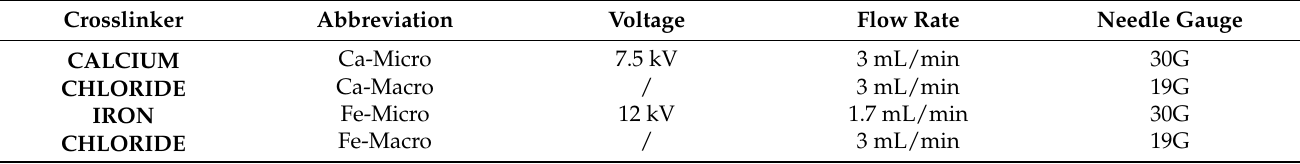
Table 1. Optimal electrospray parameters for the production of micro- and macro-sized alginate beads crosslinked with Calcium or Iron